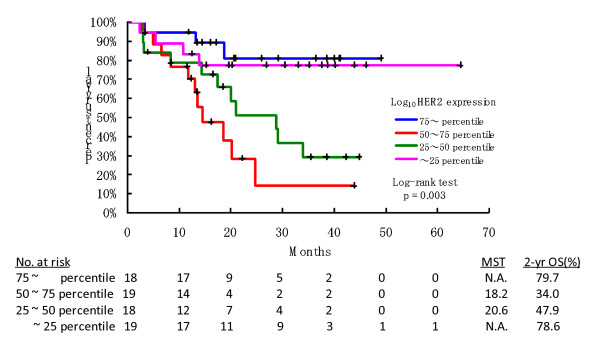
Kaplan-Meier curve of OS by HER2 expression subgroup.